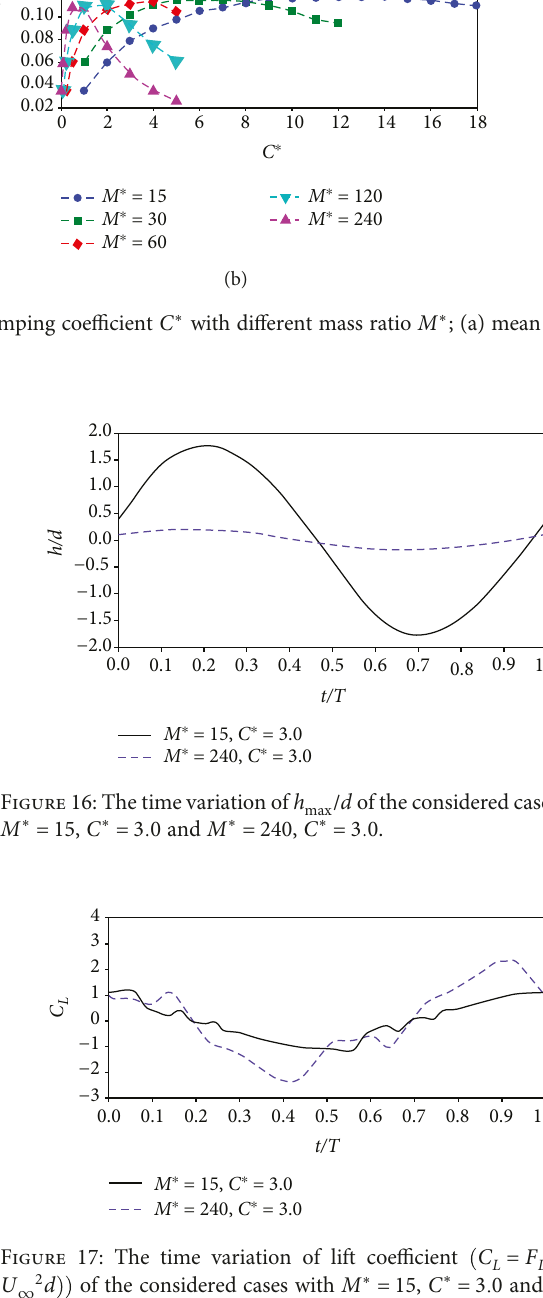
Figure 17: The time variation of lift coe ffi cient C 2 d of the considered cases with M ∗ = 15 , C ∗ = 3 0 and M ∗ = U ∞ 240 , C ∗ = 3 0 .